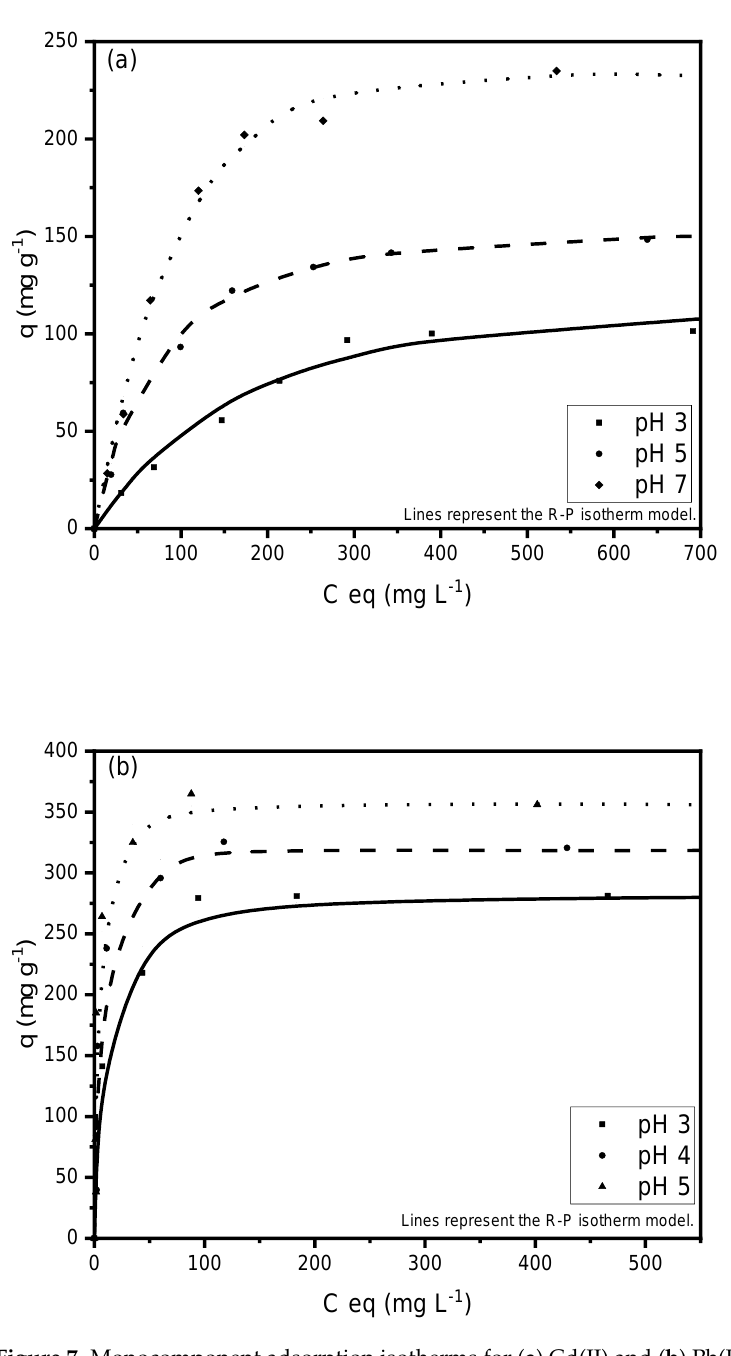
Figure 7. Monocomponent adsorption isotherms for ( a ) Cd(II) and ( b ) Pb(II) at 25 °C.